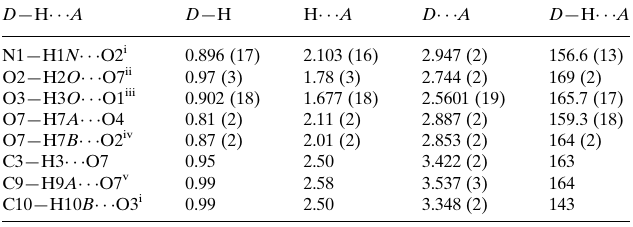
Hydrogen-bond geometry (A˚ , (cid:3)